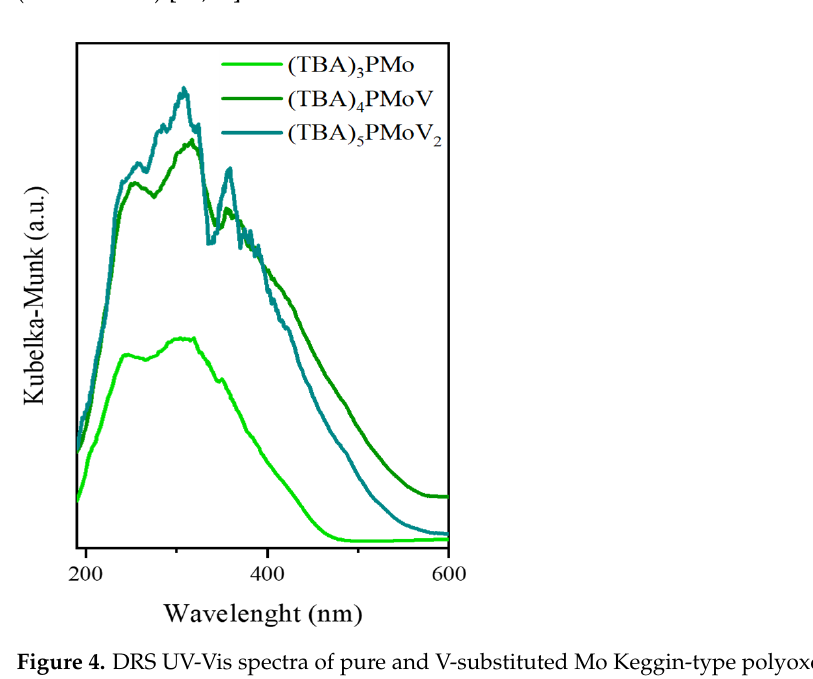
Figure 3. XRD patterns of pure and V-substituted Mo ( a ) and W ( b ) Keggin-type polyoxometalates. The red symbol represents the comparison between equivalent diffractograms with JCPDS cards.